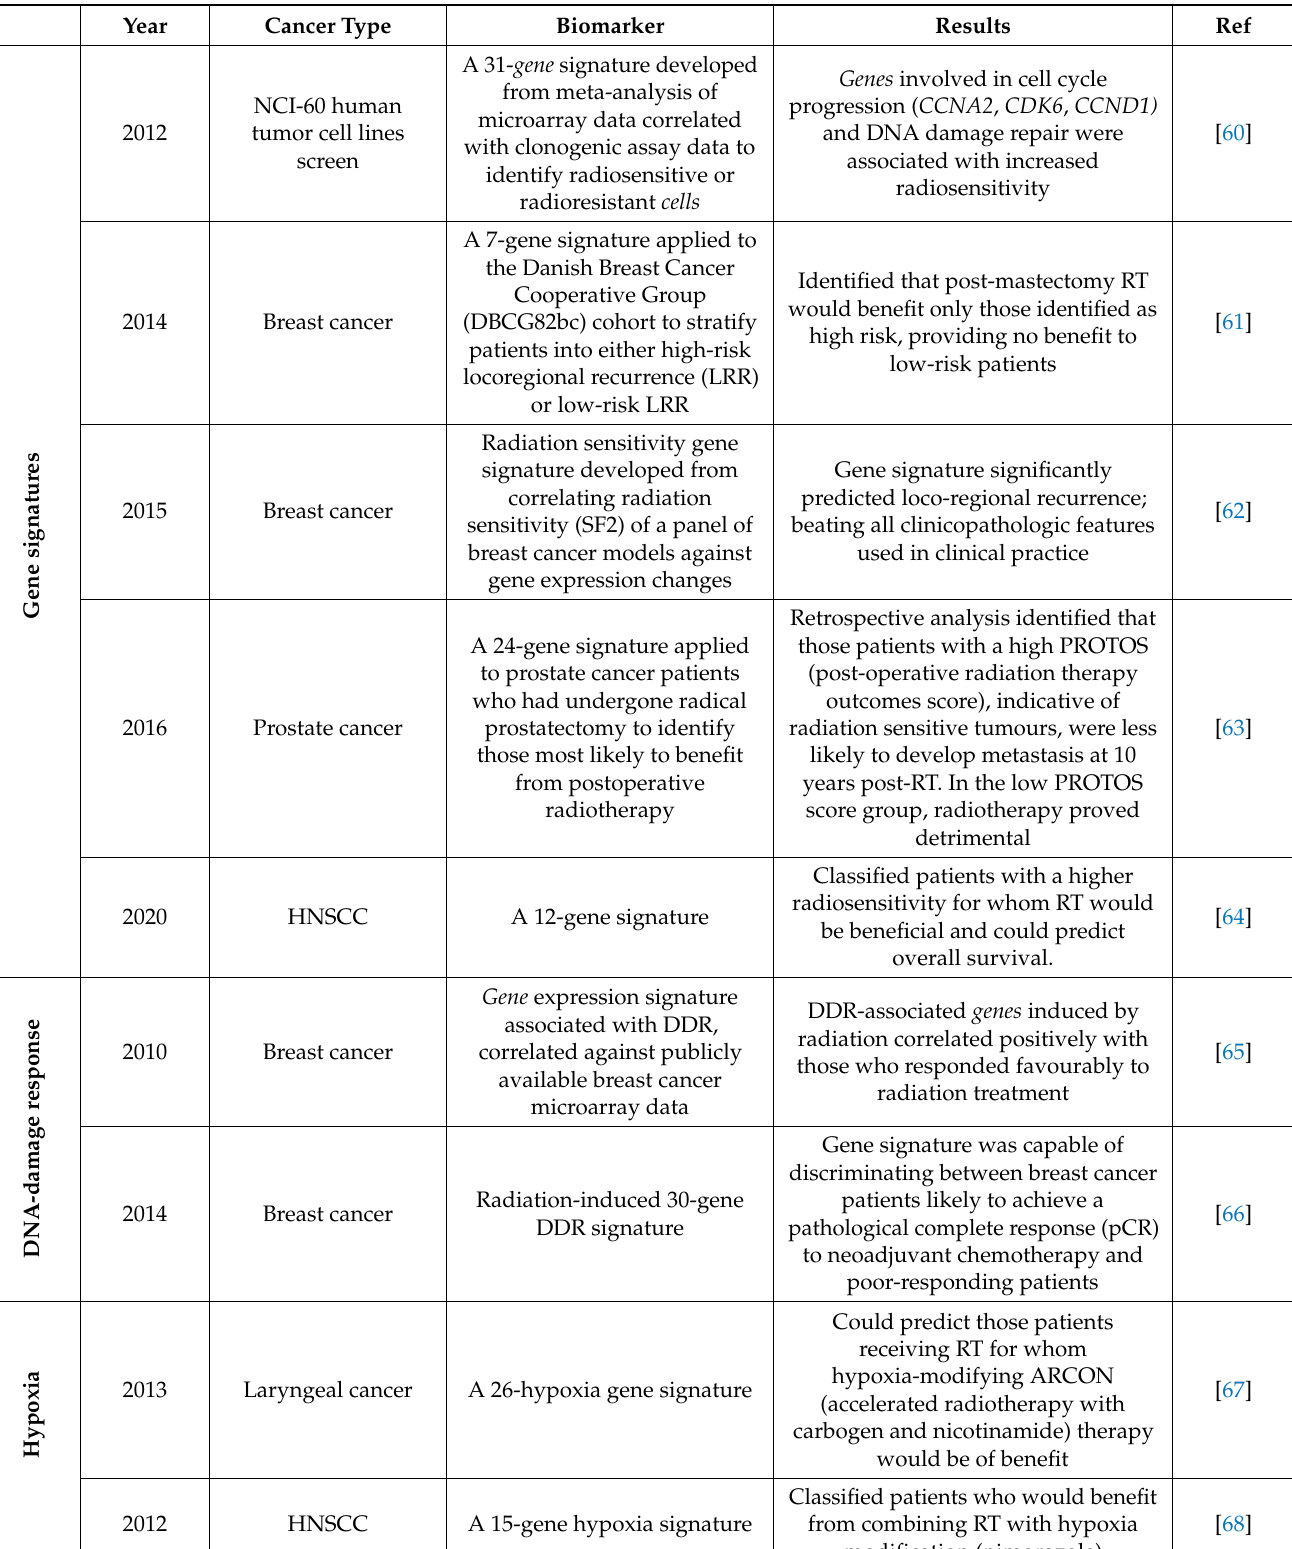
Table 1. Biomarkers of radiotherapy